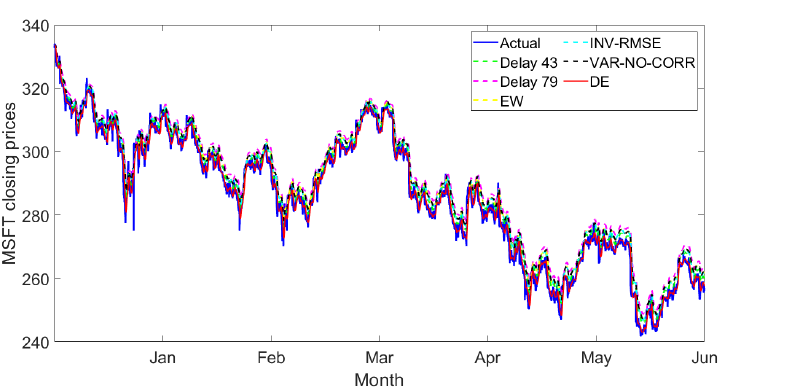
Figure 16. The forecasting curve for actual data versus the individual and combination methods of MSFT stock obtained from LSTM model between January and June 2022.